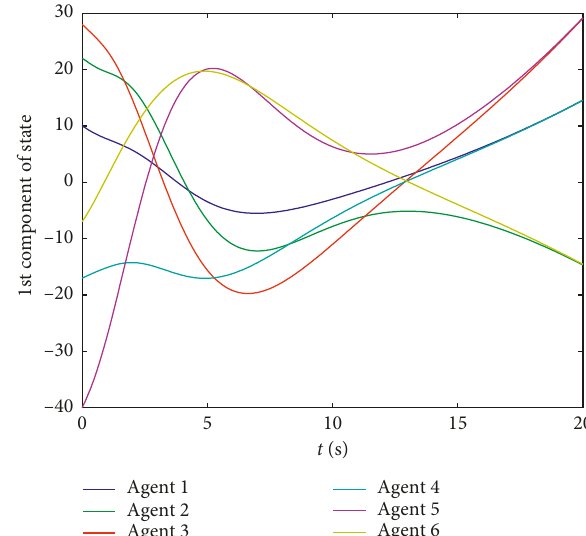
Figure 4: Trajectories of x